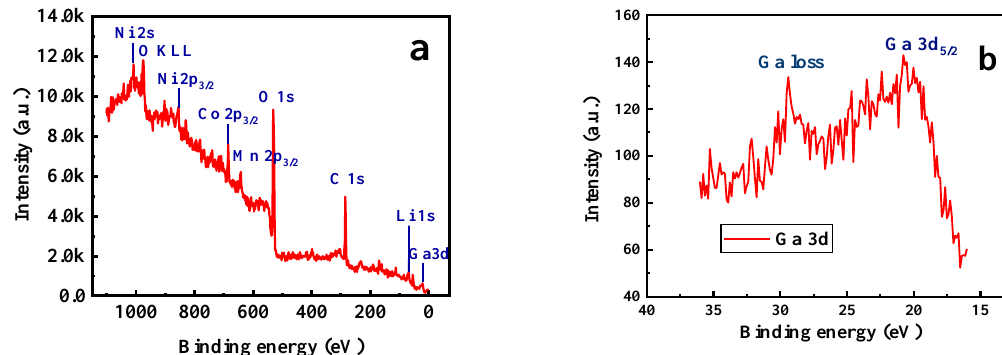
Figure 5. XPS spectra of Li[Ni 0.6 Co 0.2 Mn 0.2 ] 0.98 Ga 0.02 O 2 . ( a ) Survey scan; ( b ) Ga 3d spectra.